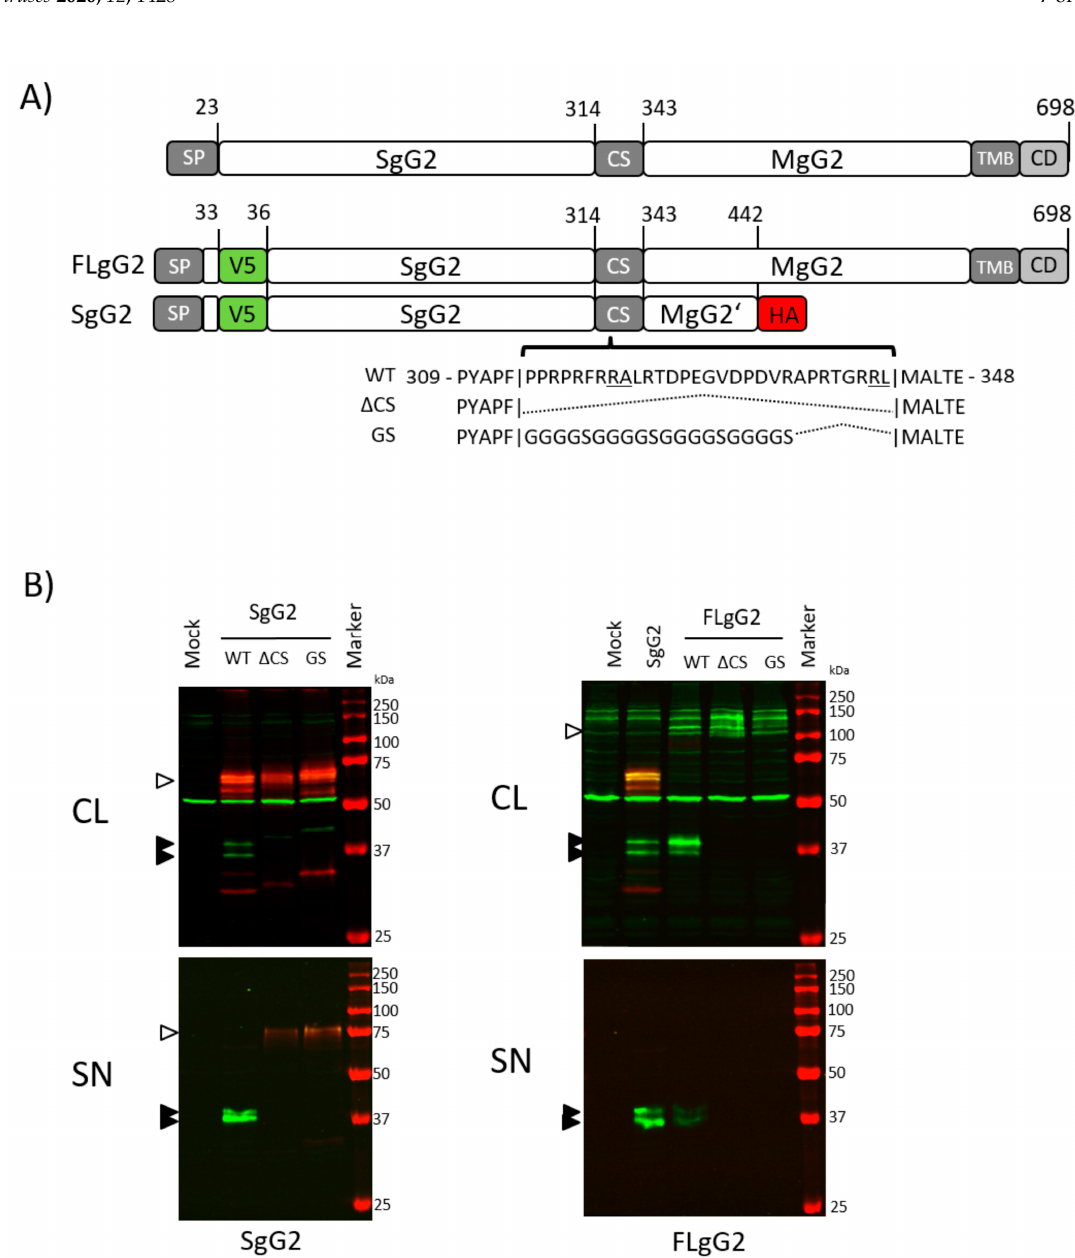
Figure 2. Deletion of the CS sequence abrogates cleavage of gG2. ( A ) Schematic representation of FLgG2 and SgG2 parental constructs used in this study, positions of V5 and HA-tags are indicated. Changes in sequence of the CS region in ∆ CS and GS mutants are given. Abbreviations are the same as described in Figure 1. Indicated amino acid positions are based on HSV-2 strain 333 gG2 WT sequence. ( B ) Detection of gG2 proteins in cell lysates and culture supernatants using anti-V5 (green) and anti-HA (red) antibodies. Molecular weight of bands in the protein marker are indicated. Black arrowhead indicates SgG2 cleavage products, and white arrowheads indicate precursor proteins. Abbreviations: CL, cell lysate; SN, supernatant. One of four independent experiments is